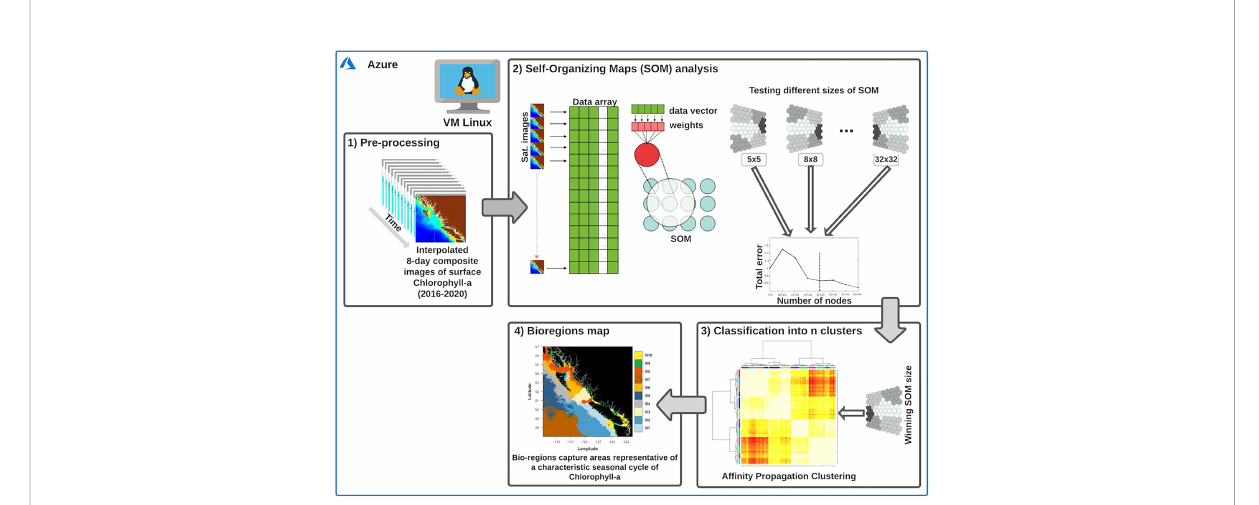
FIGURE 3 Outline of the two-step classi fi cation procedure performed on the Azure virtual machine to obtain the bioregions. The interpolated 8-day composite images of chlorophyll-a (box 1) represent the primary input for the Self-Organizing Map (SOM) analysis (box 2). As a second step, an Af fi nity Propagation clustering algorithm (box 3) was used to reduce the number of units (i.e., nodes) from the initial SOM partition into an objective number of clusters (box 4). For more detailed information on the two-step classi fi cation procedure, sees section 2.2. Modi fi ed from Liu and Weisberg (2011) and Fendereski et al.